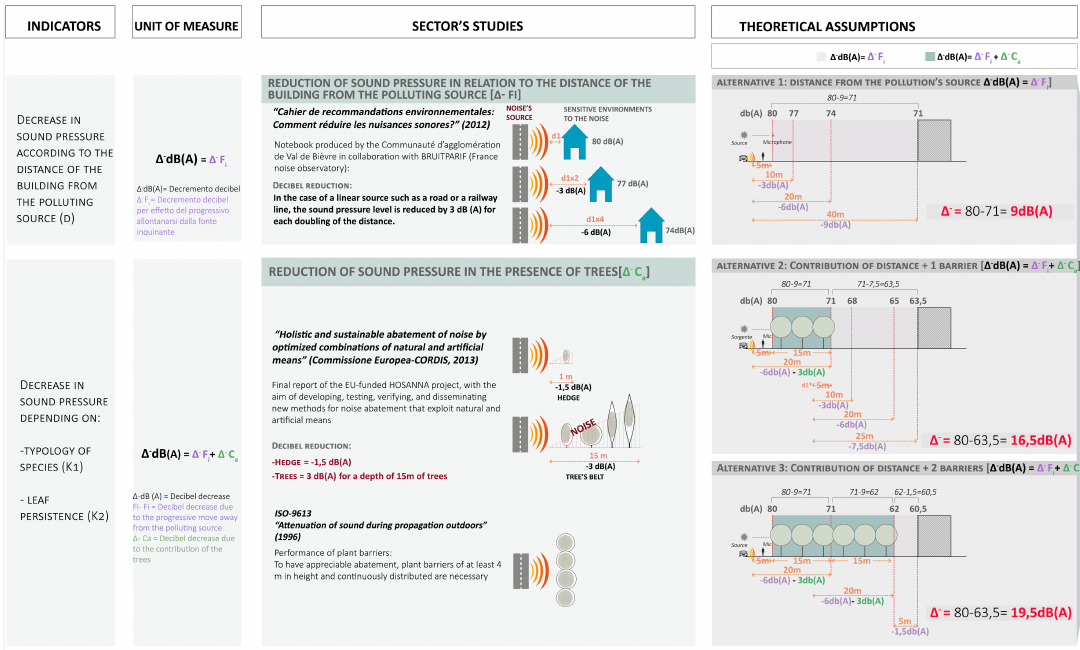
Figure 5. Theoretical scheme of the procedure adopted for the determination of the sound pressure reduction due to the insertion of tree elements and the building layout on the area of